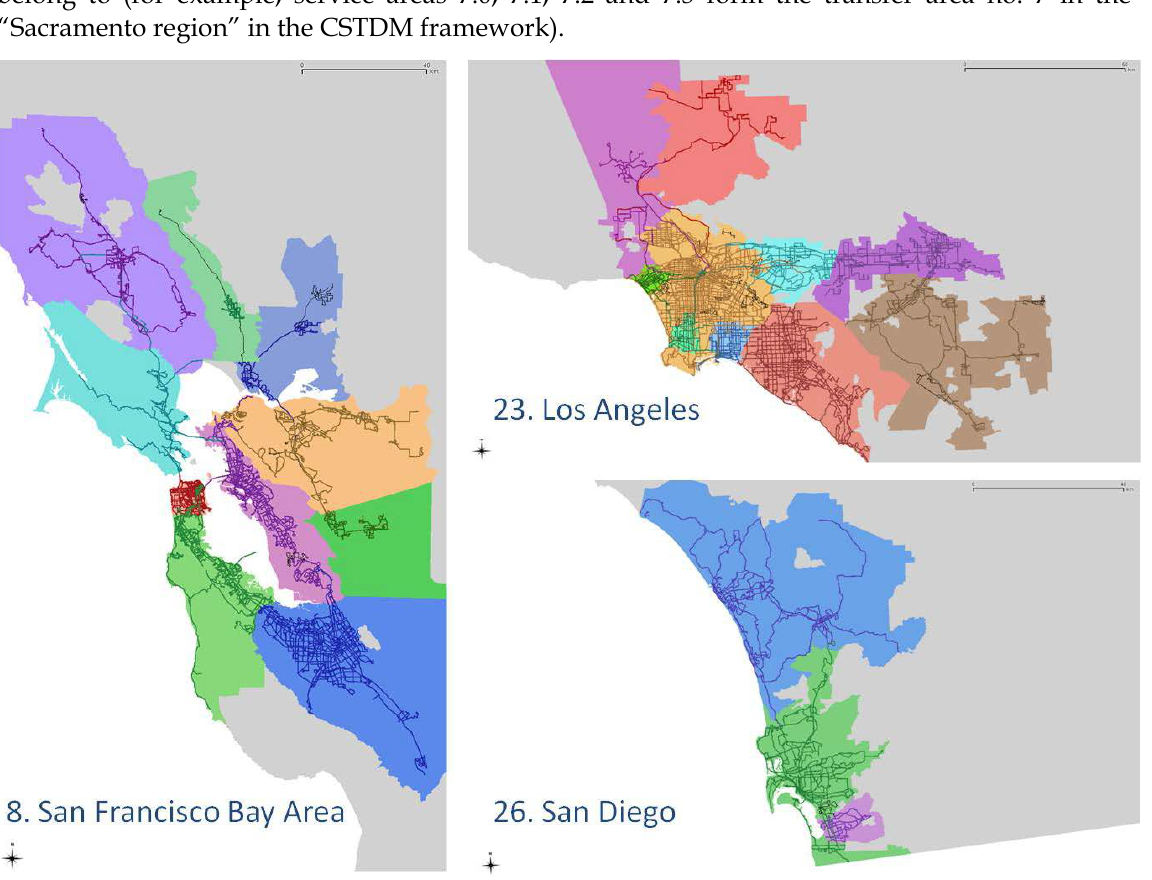
Figure 2. Local Transit Catchment Areas (Transfer and Service Areas) in the CSTDM system for three of the four major metropolitan areas of California: 8. “San Francisco Bay Area”; 23. “Los Angeles”; and 26. “San